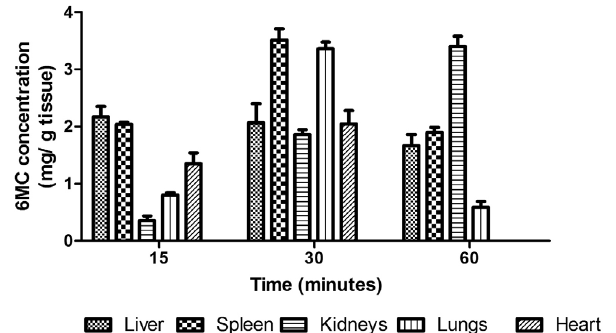
FIGURE 4 - Biodistribution profile of 6-methylcoumarin after oral administration in Wistar rats. Data expressed mean ± D.S of five animals. Dose administered 200